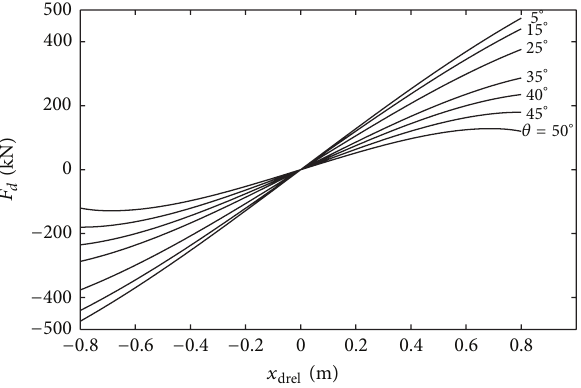
for various configurations 𝜃 drel